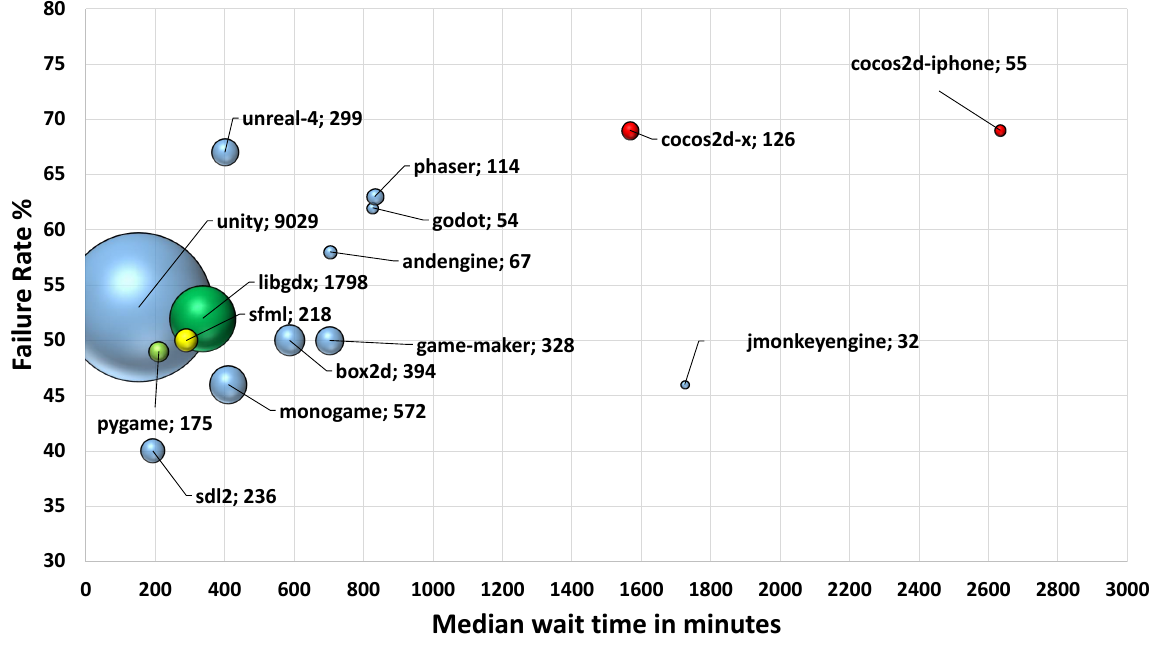
Figure 3. Failure Rate and Median Wait Time for Game Engines and Development Frameworks. Three-dimensional software for asset creation: When it comes to 3D software used to create assets, established software such as Blender , 3DS Max , and Maya all have a failure rate upwards 60%. In particular, nearly 75% of questions tagged with Maya do not have accepted